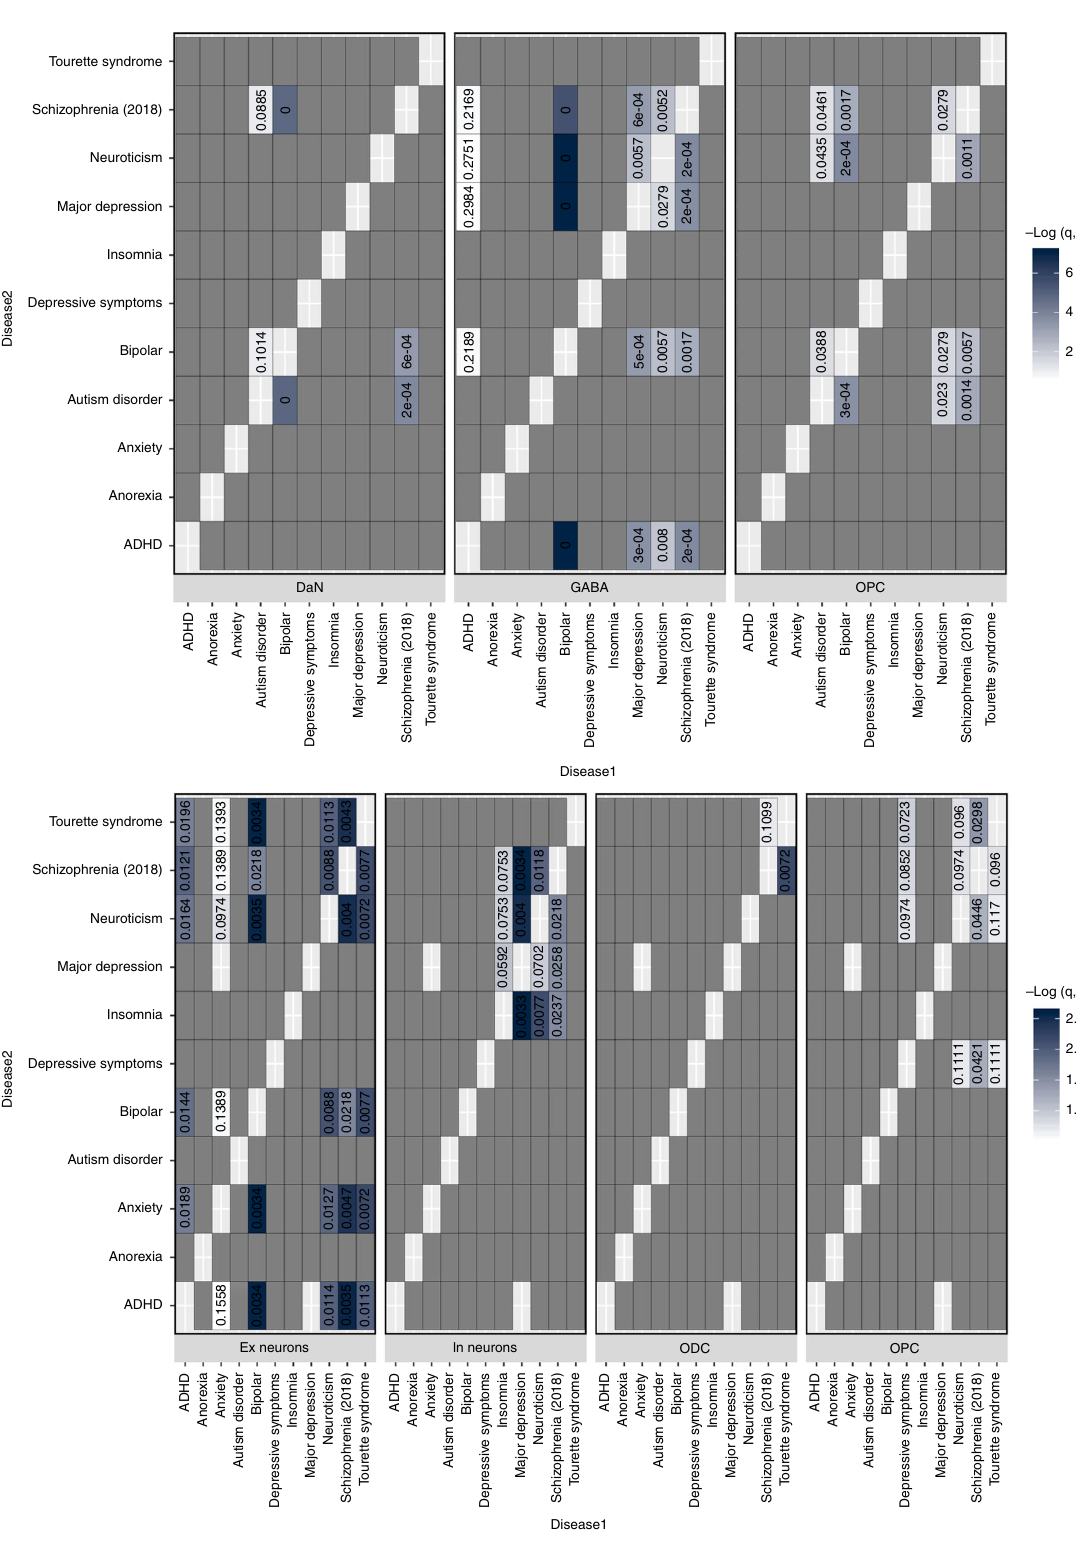
Fig. 3 Evaluation of the shared cell-type associations between pairs of neuropsychiatric disorders. Evaluation of alike cell-type associations between any two neuropsychiatric disorders to identify any shared cell-type-speci fi c component of risk, for the SN cell types (top) and the cortex (bottom). Each heatmap represents the results from LDSC of the associations ( p value associated with an LDSC coef fi cient) of a speci fi c cell-type expression pro fi le with the genetic risk of a given neuropsychiatric disorder (disease1 — X -axis) after conditioning on the genetic risk of another neuropsychiatric disorder (disease2 — Y -axis). This analysis was only performed where two neuropsychiatric disorders showed a signi fi cant (or suggestive) association with the same cell type (Fig. 2). The blue heatmap colours are proportional to − log 10 q value (FDR-adjusted p value) of the enrichment of genetic variants associated with a disorder adjusted for another disorder. The cell associations that were not evaluated (no overlap in Fig. 2) are coloured in dark